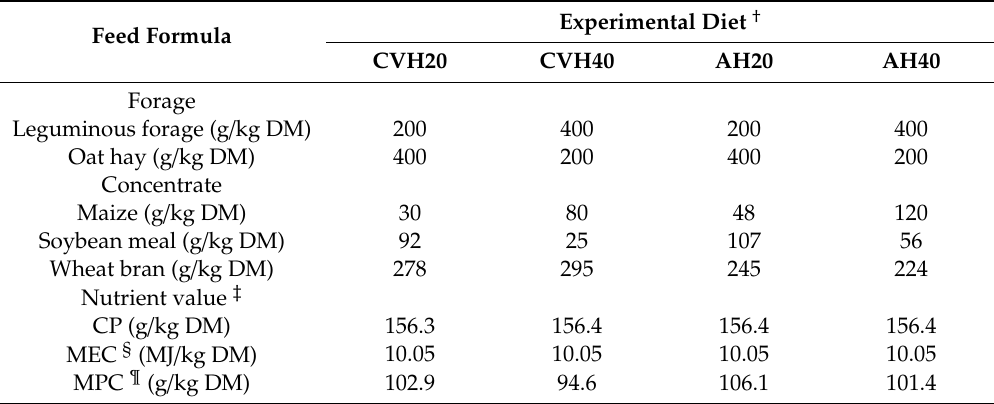
Table 2. Composition of the feed ingredients and the target metabolizable energy concentration and metabolizable protein concentration of all